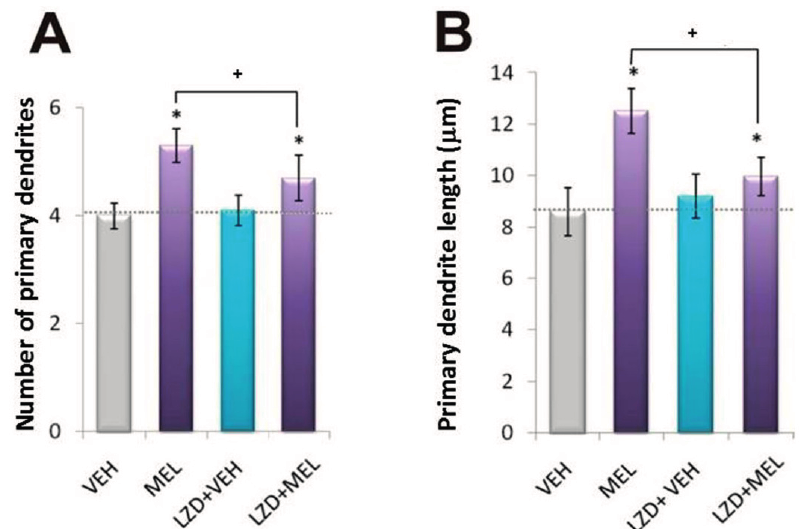
Figure 6. Participation of Melatonin receptors on dendrite formation elicited by Melatonin. To evaluate the involvement of MEL receptors, hippocampal organotypic cultures were incubated with the MT1/2 receptor antagonist, luzindole. Thus, rat brain hippocampus was cut in 400 µm slices and cultured in Neurobasal ® media for 7 days. Then they were incubated for 6 h with either the vehicle ( A ); 100 nM melatonin ( B ); or pre-incubated with 100 µM luzindole followed by 6 h incubation with the vehicle ( C ) or 100 nM melatonin ( D ). After the incubation time, slices were cut into 50 µM sections and immunostained for the specific marker of dendrites MAP2. Images were acquired with a camera coupled to a light microscope with the NIS-Elements software. Scale bar = 100